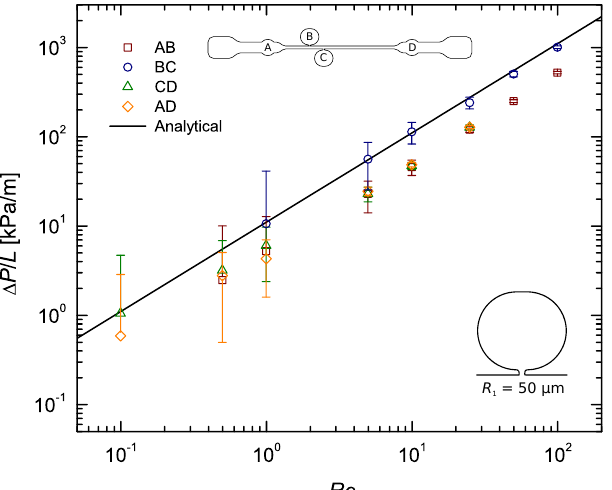
Figure 5. Pressure gradient as a function of the Reynolds number for the flow of DI water along a rectangular microchannel: Pressure tap with sub-channel width w 2 = 108 µ m and sub-channel–tap radius R 1 = 50 µ